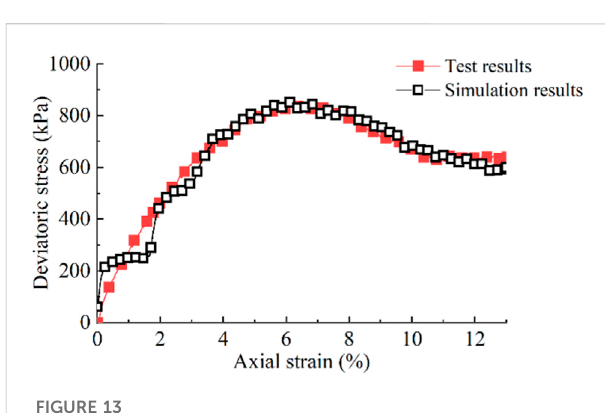
FIGURE 13 Comparison of deviatoric stress – strain between simulation and the indoor